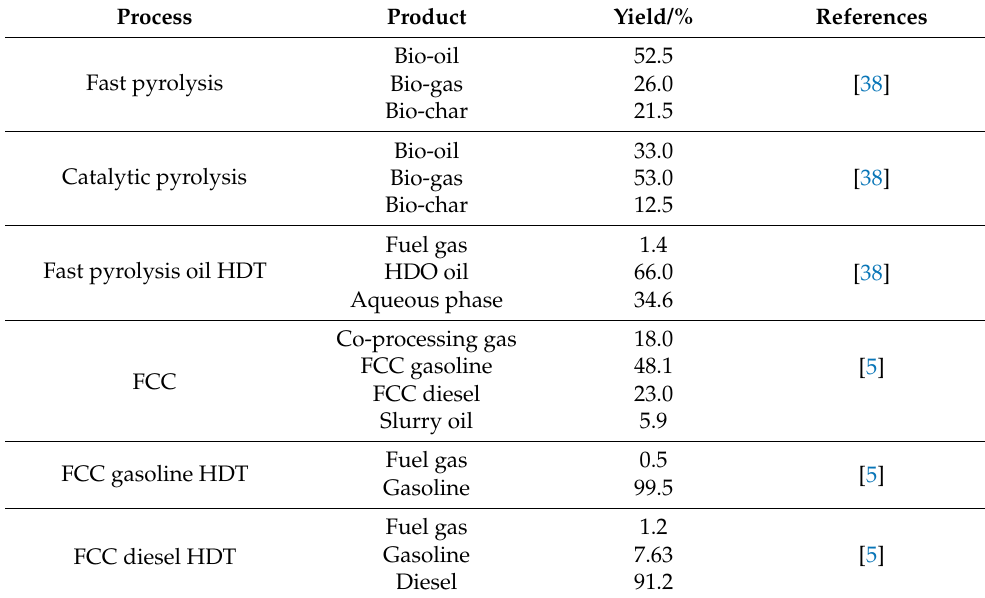
Table 6. Product yields of all the related processes.